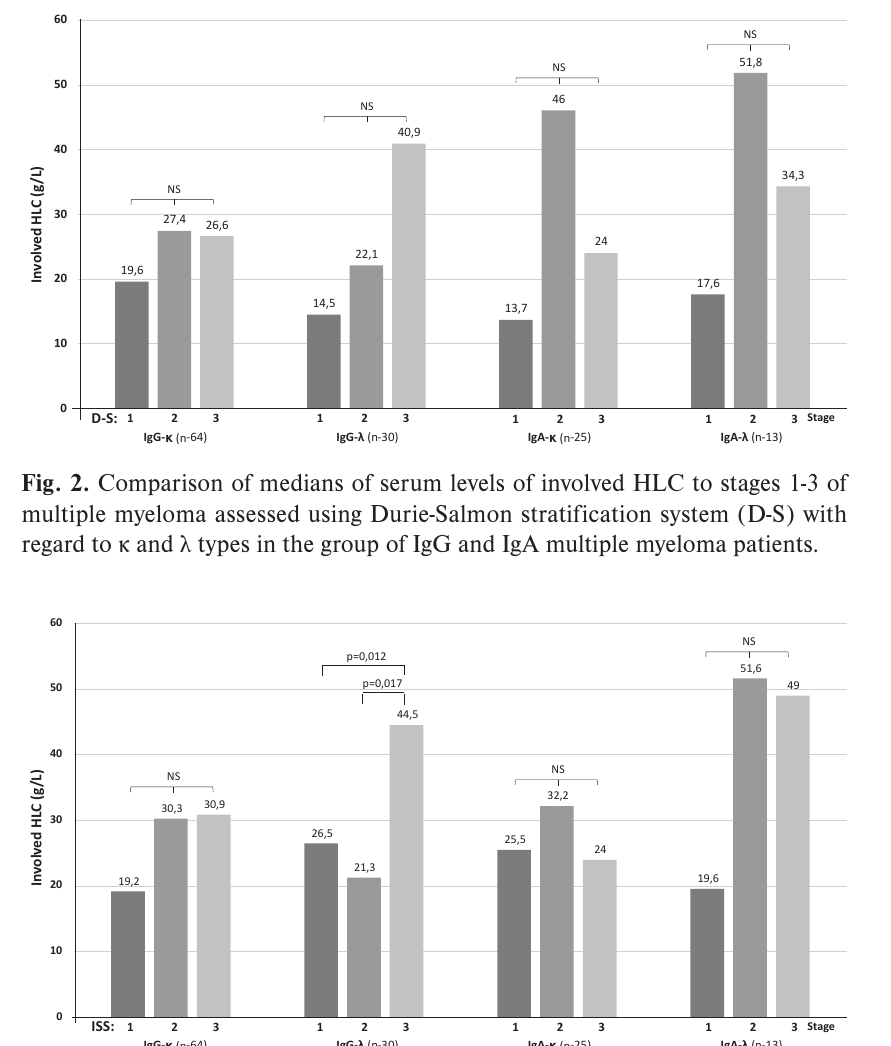
Fig. 1. Comparison of HLC-r index (HLC-κ/HLC-λ) and x HLC-r (HLC-λ/HLC-κ) with the stage of multiple myeloma (stage 1-3 and substage A-B) assessed using Durie-Salmon (D-S) and International Staging System (ISS) in the group of IgG and IgA multiple myeloma patients.